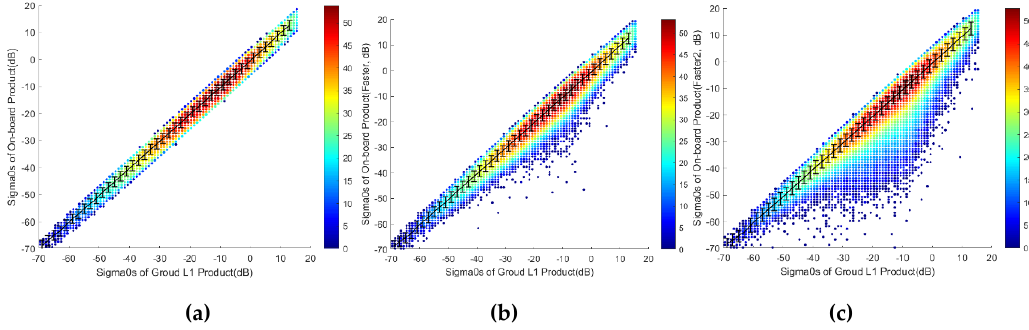
Figure 7. Correlation and error bars of NRCS for ground products (vertical axis) and on-board products (horizontal axis). Color indicates sample number density in dB. ( a ) illustrates results from LUTs in full resolution, and in in a half ( b ) and a quarter ( c ) number resampled LUTs. Table 2. Values from Figure 7. Stdev.(dB)